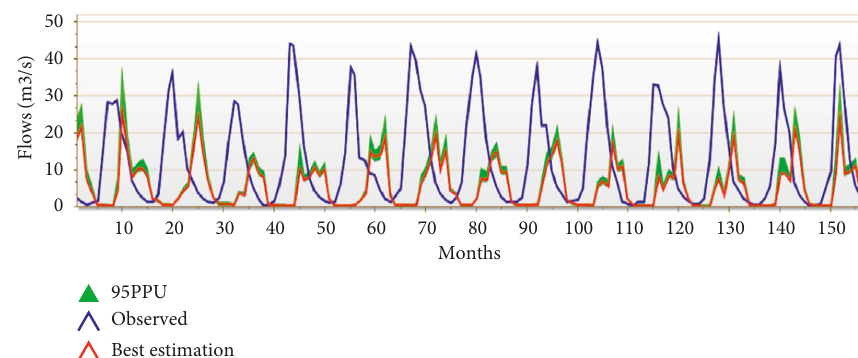
Figure 4: Calibration of streamflow result by RACMO22T model.